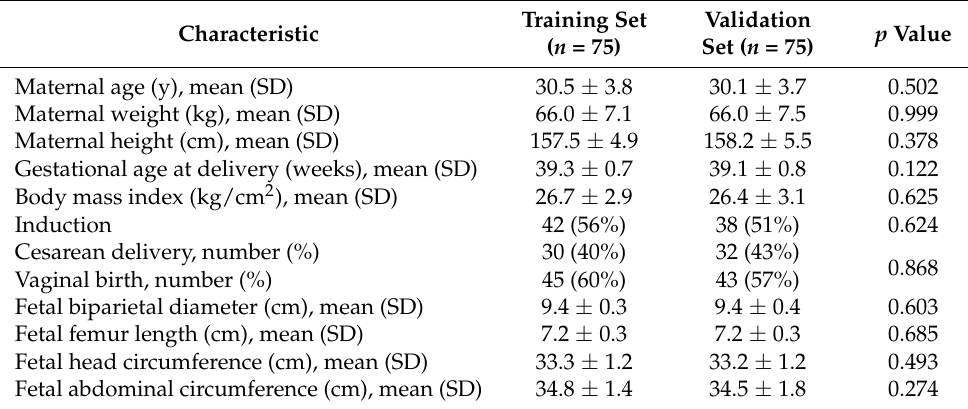
Table 1. The Demographic Characteristics and MRI